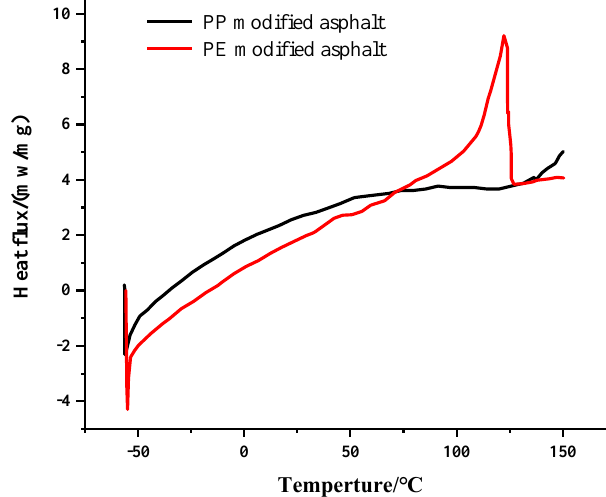
Figure 11. Thermal analysis curve of plastic-modified asphalt.